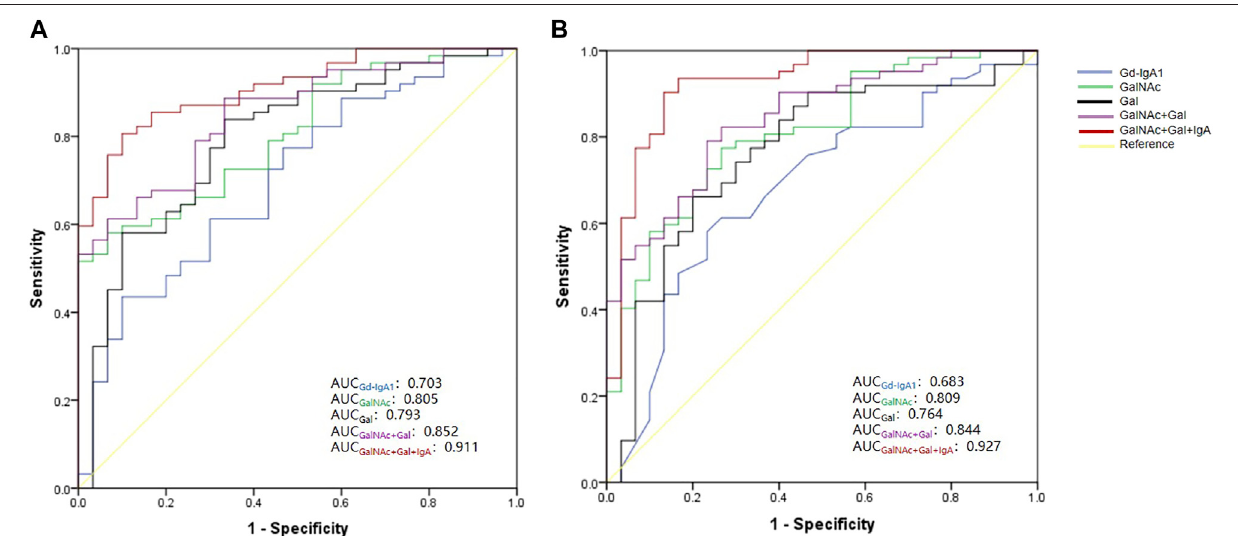
FIGURE 6 | ROC curve for fi ve biomarkers — Gd-IgA1, GalNAc number, Gal number, combined GalNAc-Gal and GalNAc-Gal-IgA Panel for the diagnosis of IgAN. (A) ROC curve analysis between IgAN and DC group. The AUC for GalNAc-Gal-IgA Panel was higher than those for Gd-IgA1, GalNAc, Gal and GalNAc-Gal (GalNAc- Gal-IgA panel vs. combined Gal and GalNAc, p = 0.029; GalNAc-Gal-IgA panel vs. GalNAc, p = 0.004; GalNAc-Gal-IgA panel vs. Gal, p = 0.016; GalNAc-Gal-IgA panel vs.Gd-IgA1, p < 0.001). (B) ROCcurveanalysisbetweenIgANandHCgroup.TheAUCforGalNAc-Gal-IgAPanelwashigherthanthoseforGd-IgA1,GalNAc,Gal and GalNAc-Gal (GalNAc-Gal-IgA panel vs. combined Gal and GalNAc, p = 0.027; GalNAc-Gal-IgA panel vs. GalNAc, p = 0.006; GalNAc-Gal-IgA panel vs. Gal, p = 0.006; GalNAc-Gal-IgA panel vs. Gd-IgA1, p <